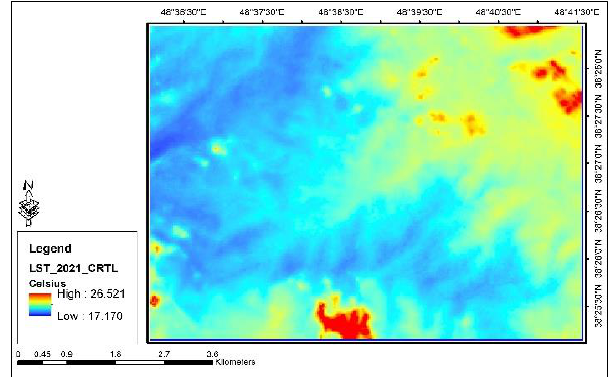
Figure 9. Calculated temperature for the control area in degrees Celsius for the year 2021.